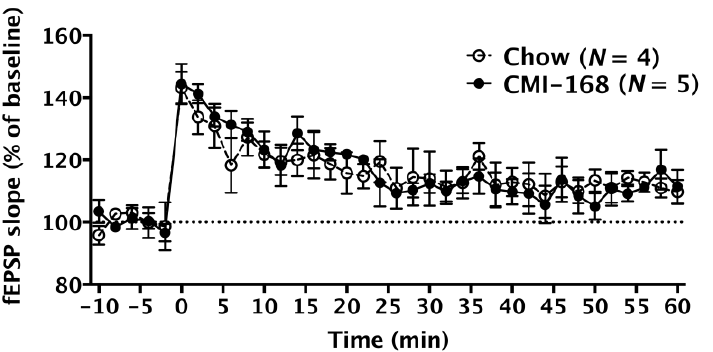
Figure 4. Effects of six-week CMI-168 dietary supplementation on the long-term potentiation (LTP) induction and maintenance in mice. The field excitatory postsynaptic potentials (fEPSP) slope (% of baseline) was recorded in the CA1 region of the Chow and CMI-168 mice before and after the LTP induction. LTP was induced by high-frequency stimulation applied to the hippocampal slices at 0 min on the timeline.